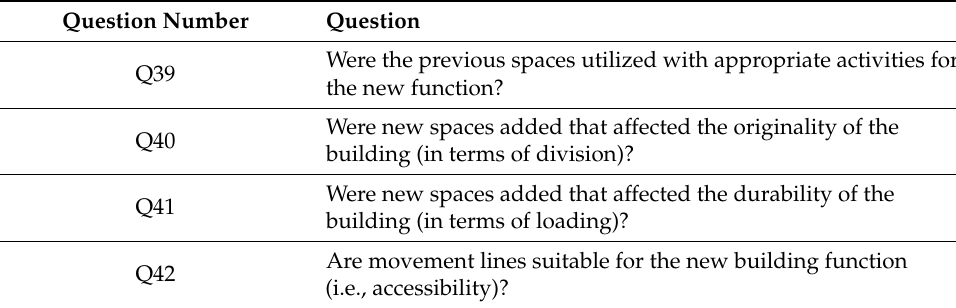
Table 7. Interior design questions (interior distribution) .